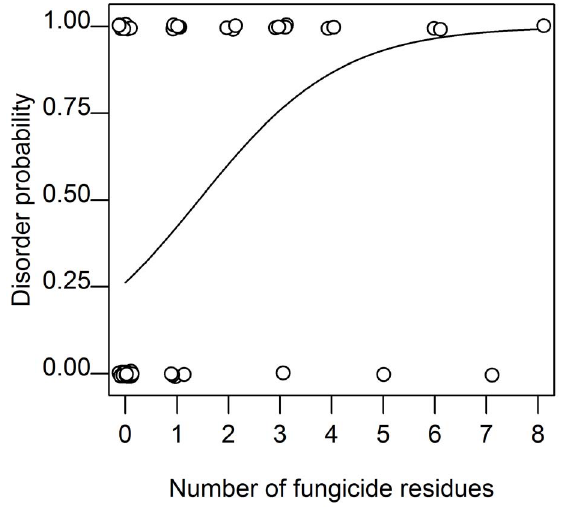
Figure 7. Probability of honeybee colony disorders depending on the number of fungicide residues detected. Model based on averaged coefficients and median value both for the number of insecticides-acaricides residues and total number of virus detected for both visits (n=53 colonies).